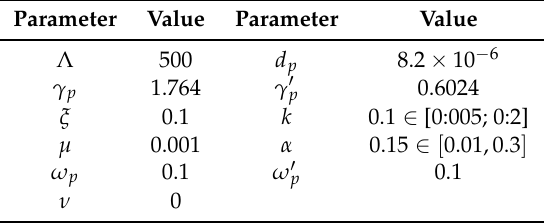
Table 3. Parameters